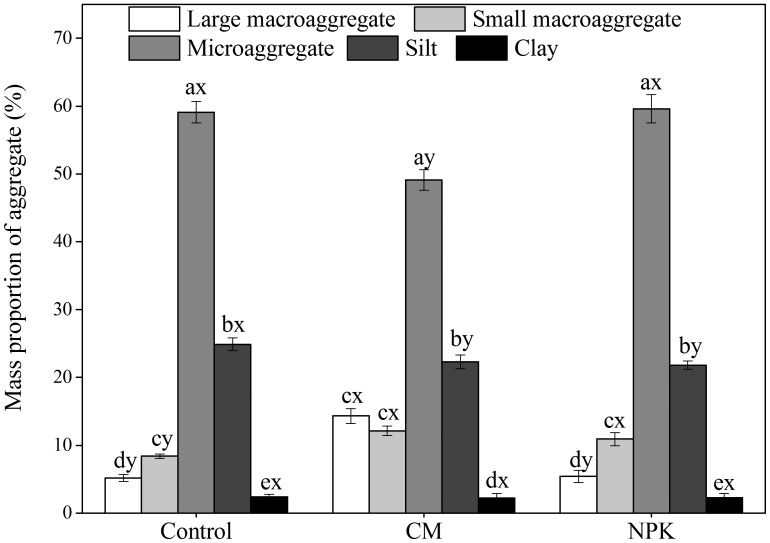
Effect of long–term applications of compost and fertilizer NPK on the mass proportion of aggregates in soil.Vertical bars indicate the standard error of the means (n = 4). Different letters denote significant differences between aggregates in the same treatment (a, b, c, d, e) and between treatments with the same aggregate (x, y, z) at P<0.05.